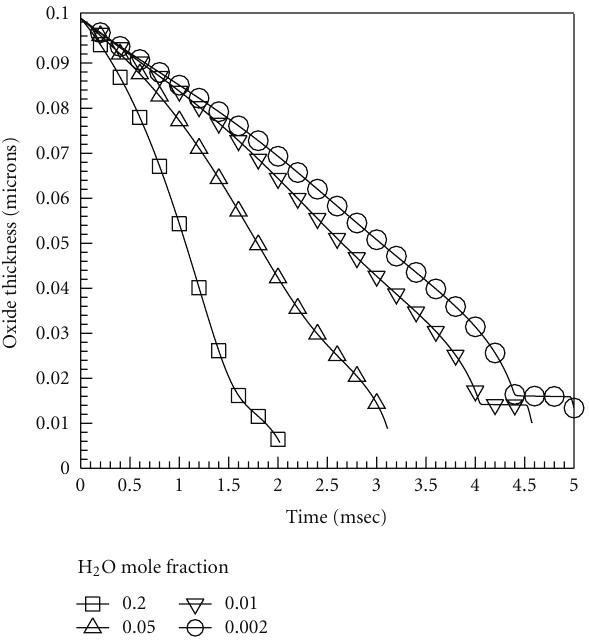
Figure 8: Oxide layer thickness versus time for various water vapor mole